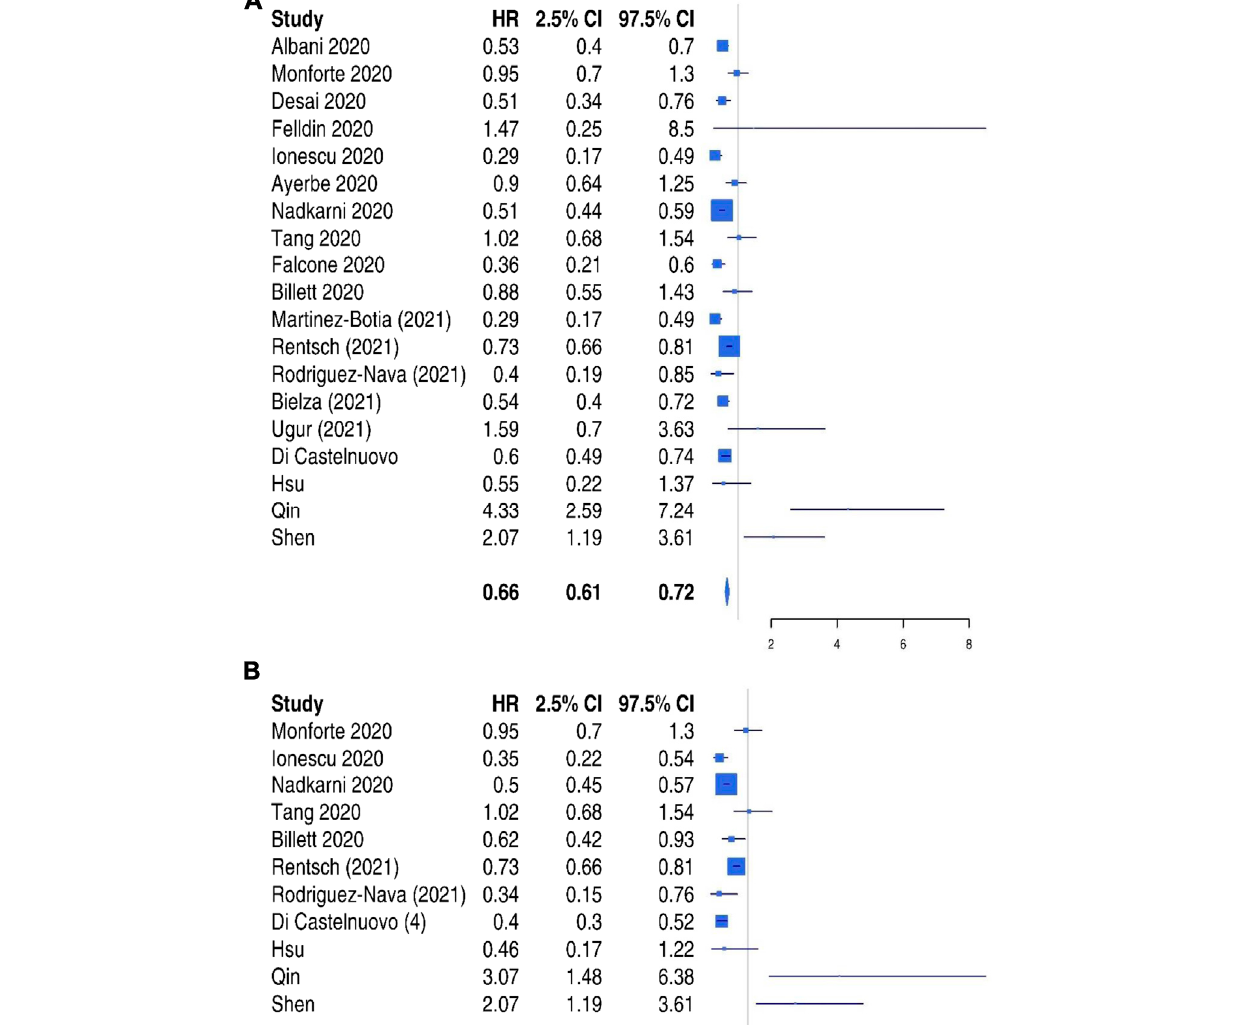
Frontiers in Pharmacology |